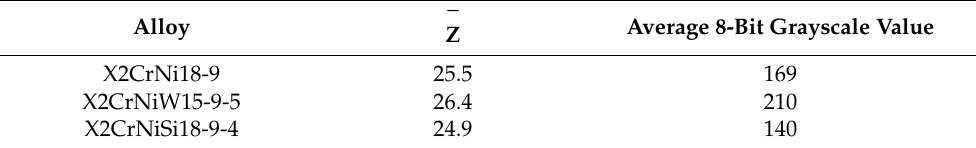
Figure 9. The CT slice image with specimens of the X2CrNi18-9X2CrNiW15-9-5 and X2CrNiSi18-9-4 steels, exhibiting different gray values due to different X-ray attenuation. Table 2. Mean atomic numbers, calculated from the measured compositions listed in Table 1, and average grayscale values extracted from the CT slice in Figure 9.